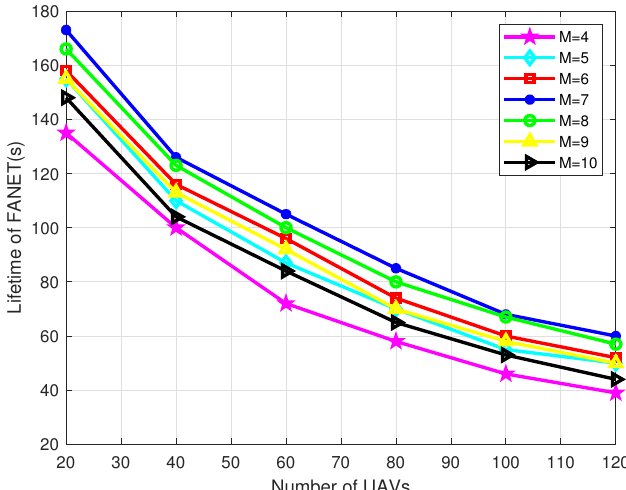
Figure 7. Lifetime of FANET in different grid partitioning conditions versus the number of UAV nodes.